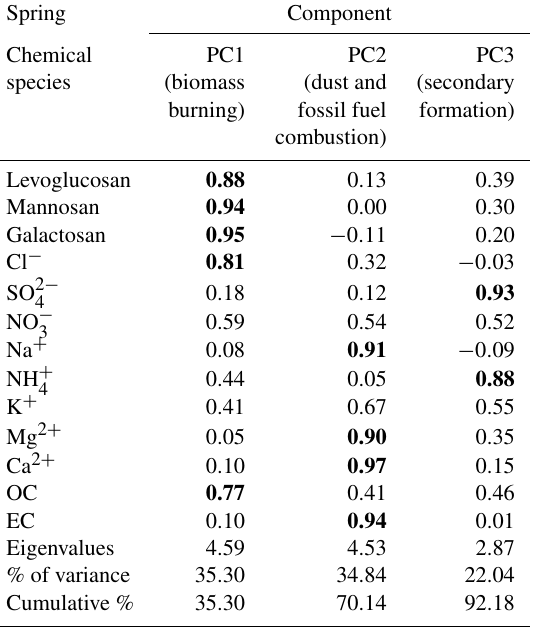
Table 3. Source identification of chemical species using PCA and varimax rotation at Ulaanbaatar, Mongolia, during the spring of 2017. Bold values show high loadings of chemical